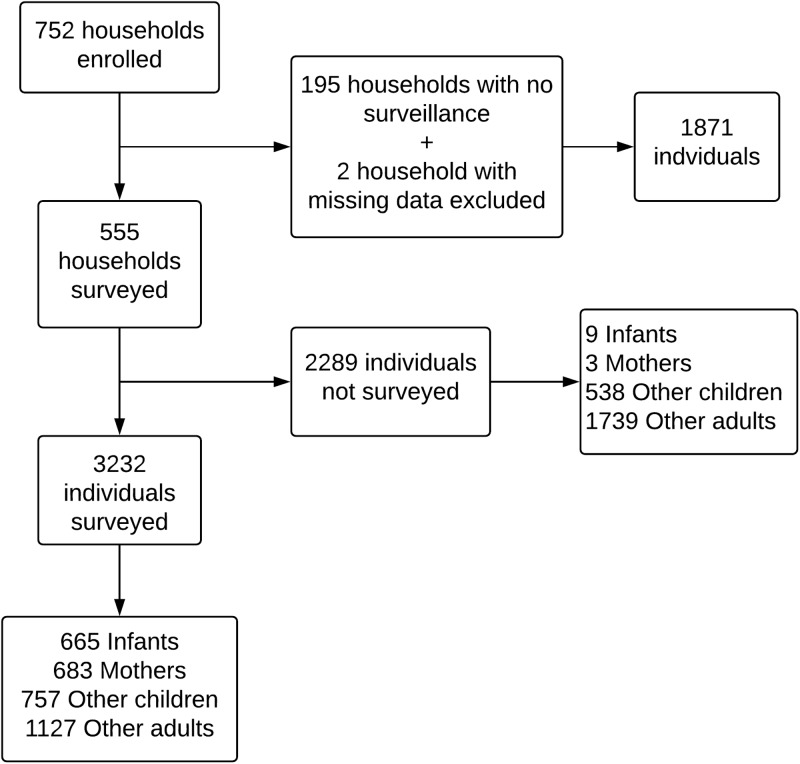
Summary of household and individual enrolment, surveillance and inclusion in the analysis of respiratory virus transmission in households in Sarlahi, Nepal.